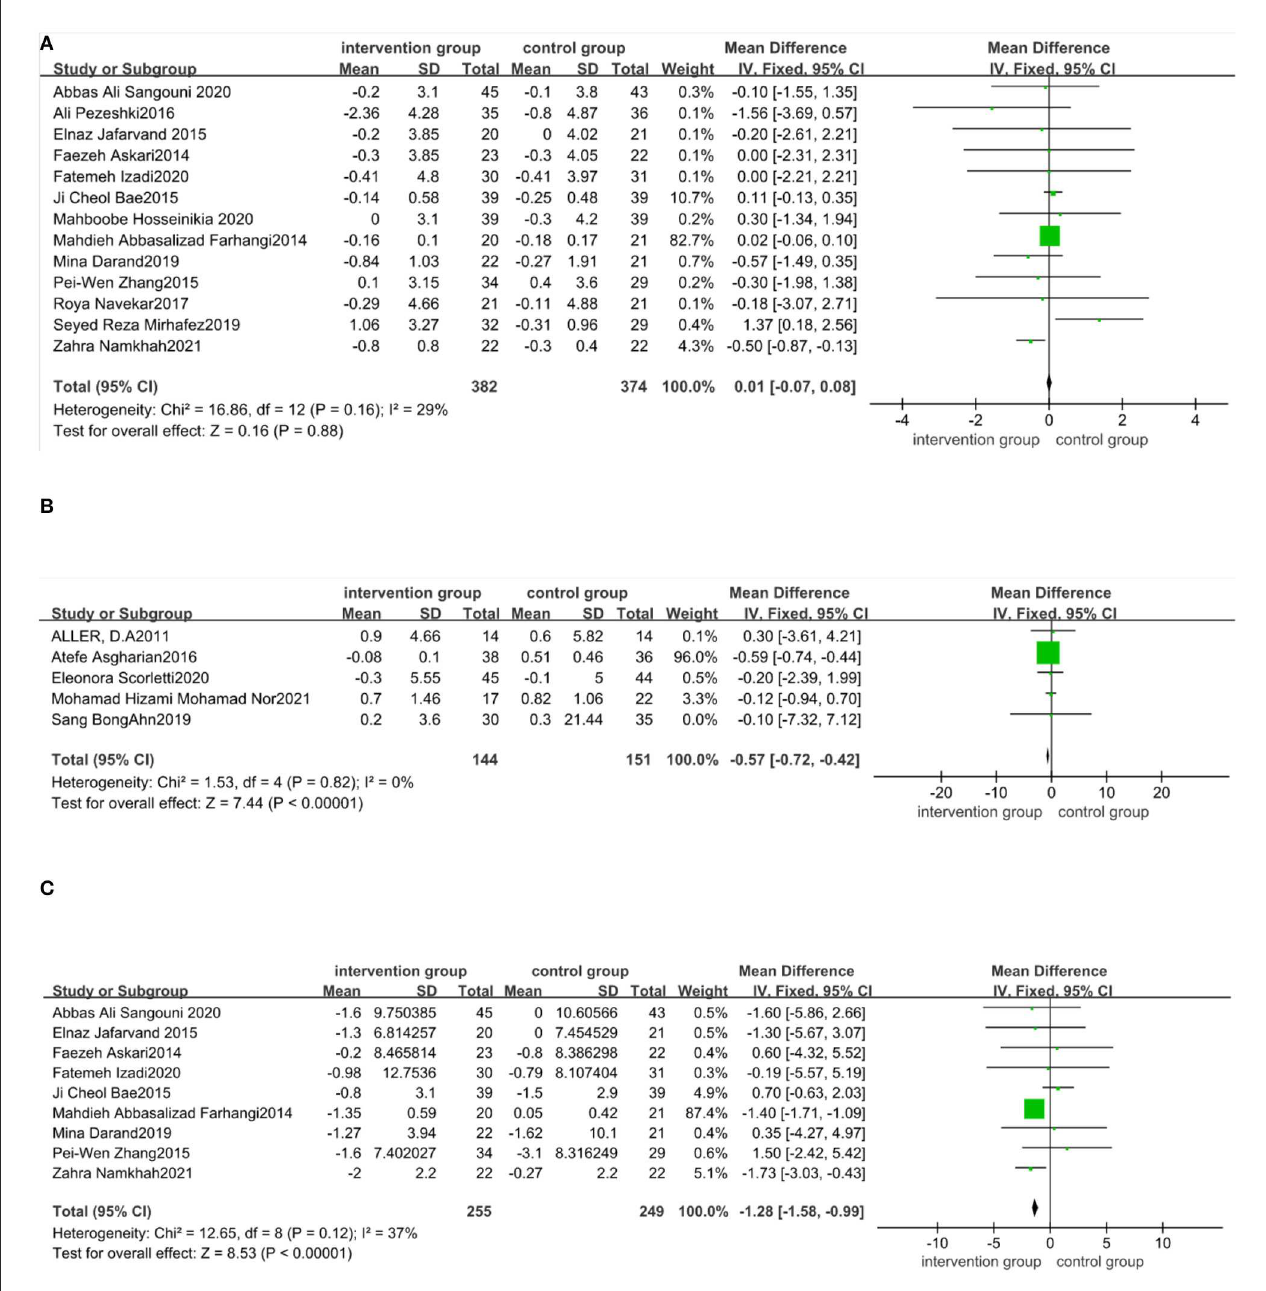
FIGURE4 Forest plot of the effect of functional foods and dietary supplements on anthropometric indices (effect of A : antioxidants on BMI; B : probiotic/symbiotic/prebiotic on BMI; and C : antioxidants on WC).